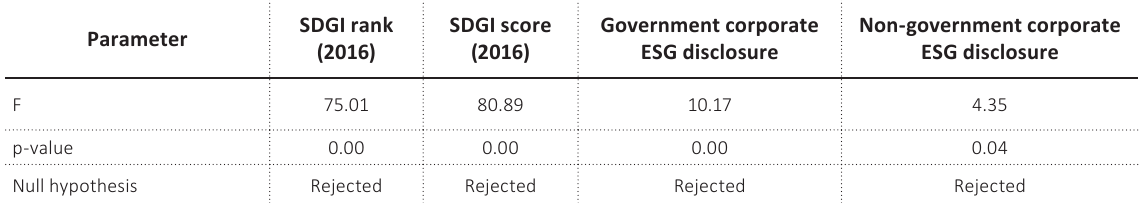
Table C2. ANOVA test of the differences between developed countries and emerging countries Parameter